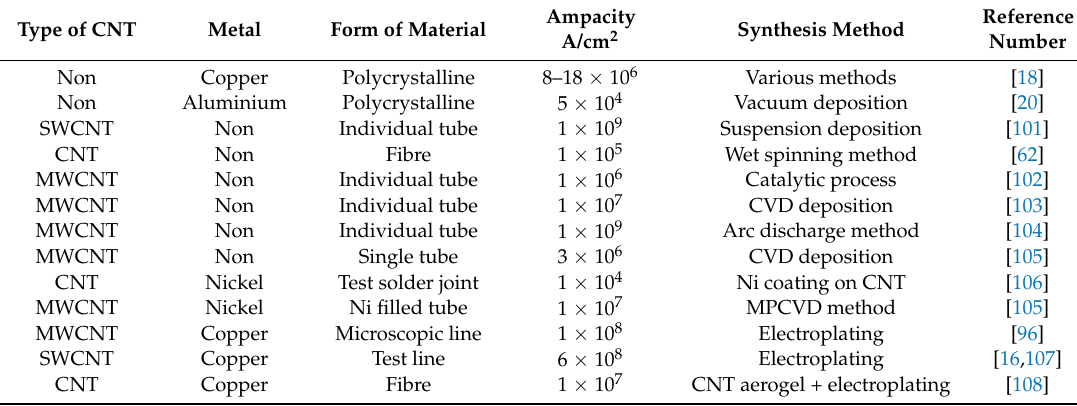
Table 1. This table summarizes the ampacity values of several materials for comparative reasons. Two purely metallic references are placed at the beginning, to illustrate how carbon nanotube technology can improve greatly on the ampacity of these materials. Both, pure carbonaceous and composite materials exhibit ampacity properties higher than any other metal reported to